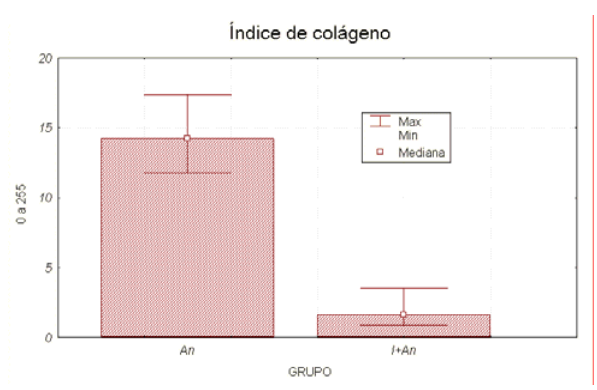
FIGURA 4 – Variação do índice de colágeno nos grupos estudados (p =